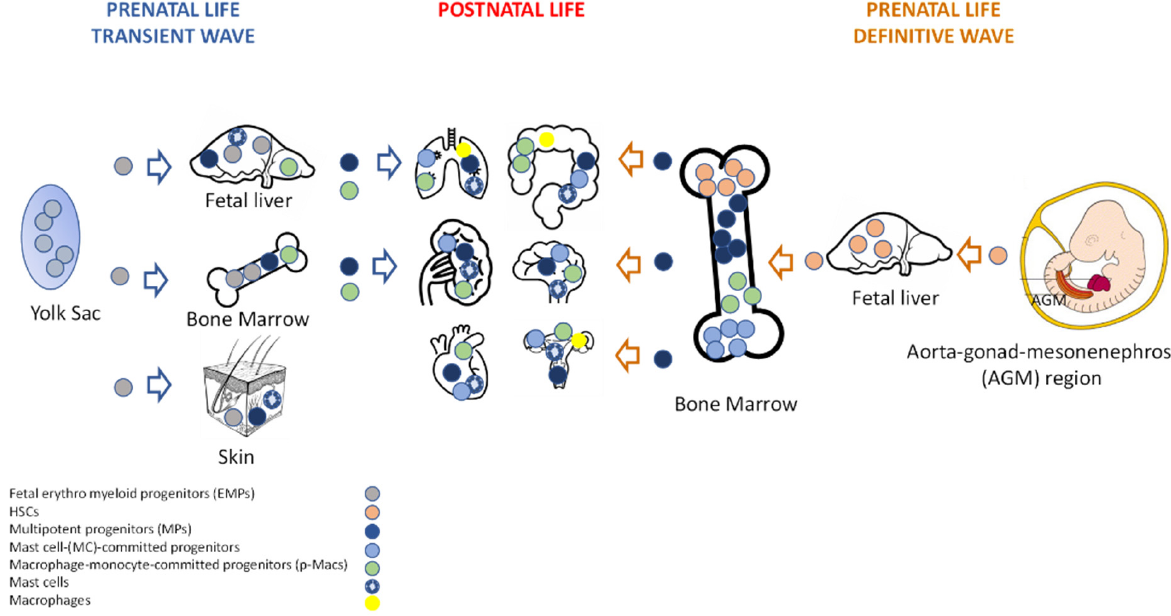
Figure 1. Schematic view of fetal hematopoiesis. Transient (definitive) and definitive waves, as well as local organ distribution of multipotent progenitors, committed-progenitors, and mature cells are shown. These sequential waves partially overlap in time and space. This figure was generated with BioRender and PowerPoint.